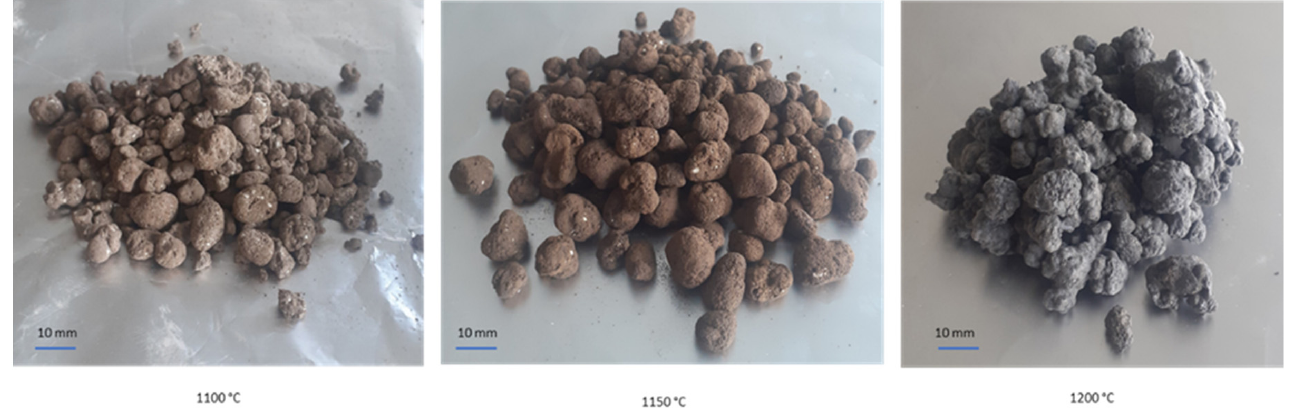
Figure 2. Sintered oxide pellets at different temperatures for C 1 A.